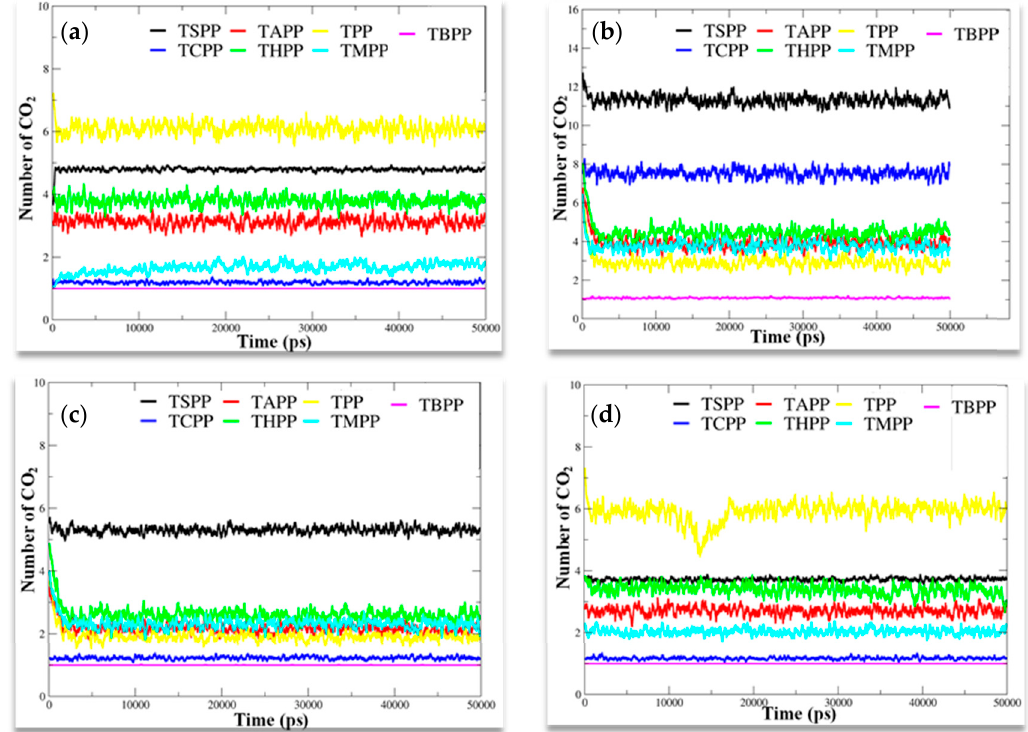
Figure 3. Number of ( a ) CO 2 , ( b ) H 2 S, ( c ) HCl, ( d ) NO 2 gas molecules in vicinity of 0.3 nm around substituents of porphyrin molecules with different substituents.